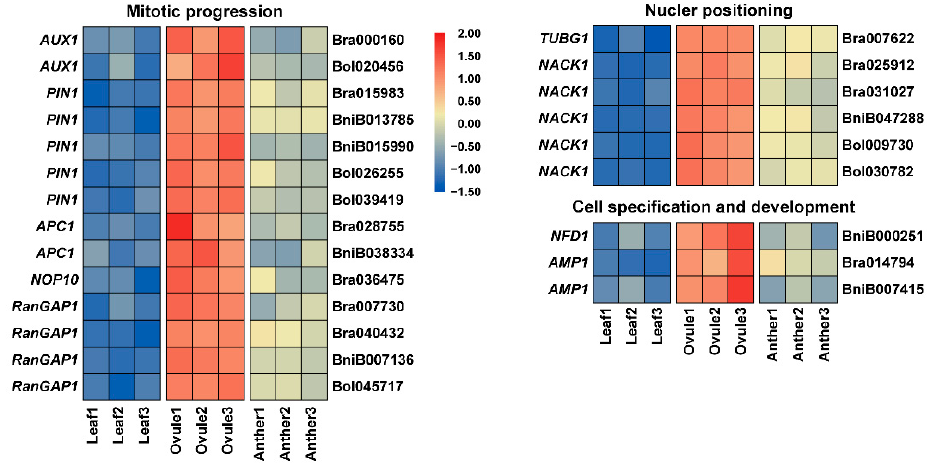
Figure 6. Identification and functional analysis of preferentially expressed genes in female gamete development of Brassica allohexaploids: ( a ) Venn diagram showing the overlap of upregulated genes between Ovule vs. Anther and Ovule vs. Leaf; and ( b ) GO biological process pathway enrichment analysis of preferentially expressed genes in Ovule.